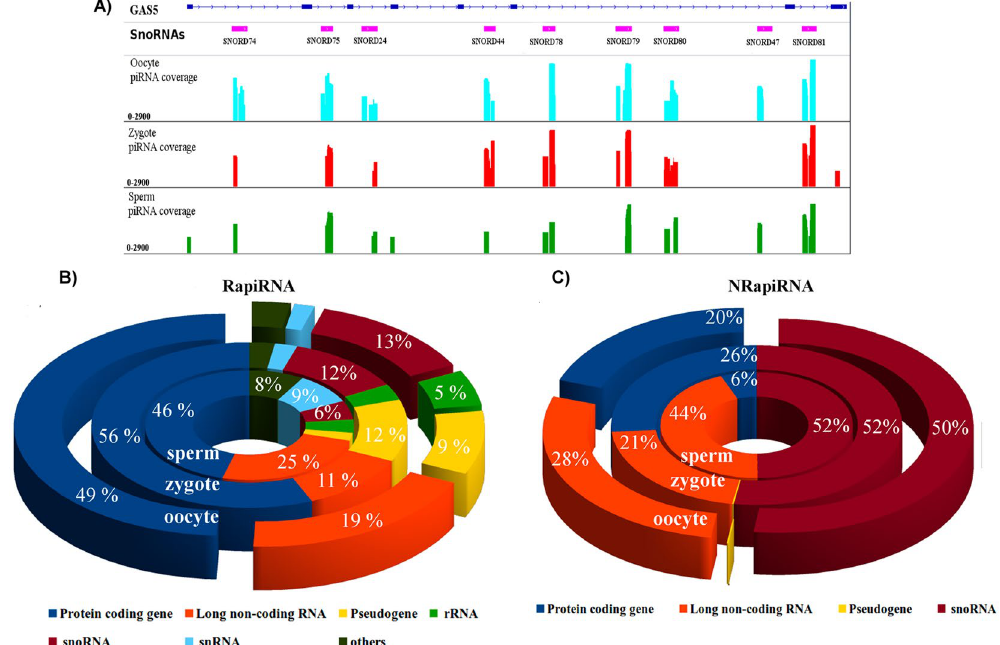
Figure 6. SnoRNA-derived piRNAs from lncRNA GAS5 and piRNA associated with gene exons. ( A ) Coverage tracks of the identified piRNAs with respect to the three cell types. Bars represent the obtained log transformed coverage values using the IGV software. GAS5 gene structure and snoRNAs were obtained from the Ensembl database. Circular diagrams show the exon associated RapiRNA read distribution ( B ) and NRapiRNAs ( C ). Biotype gene classifications according to the Ensembl